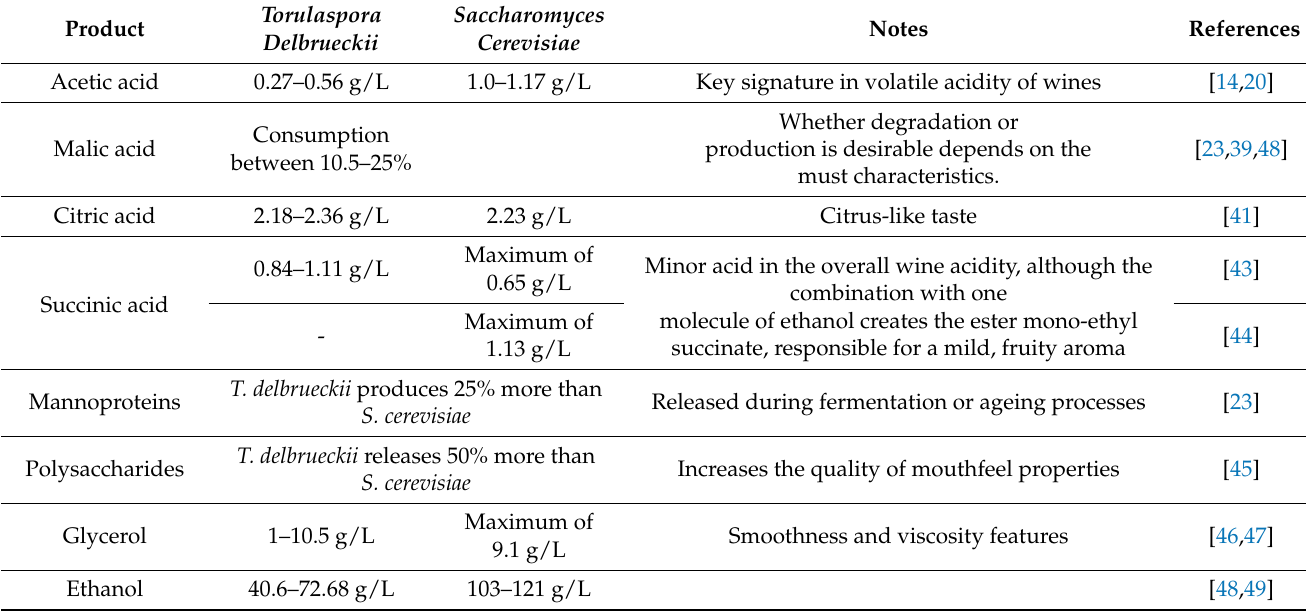
Table 1. Comparison between Torulaspora delbrueckii and Saccharomyces cerevisiae concerning fermentation parameters quantified at the end of fermentation process with relevance in wine organoleptic